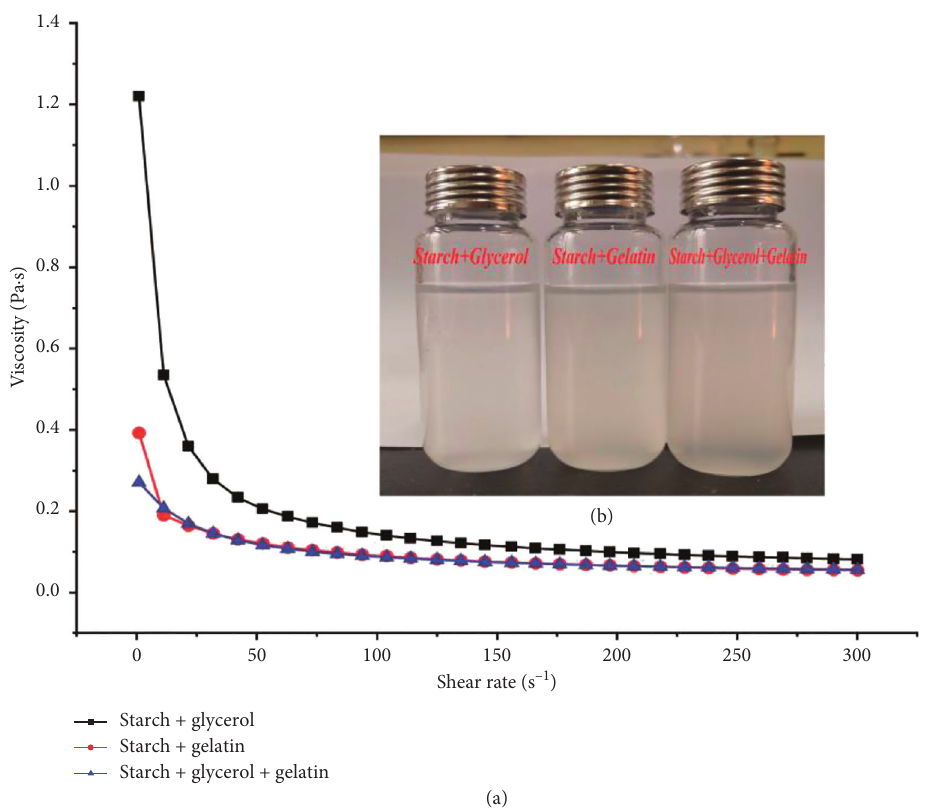
Figure 3: (a) Shear viscosity curves. (b) Pictures of film-forming solutions.